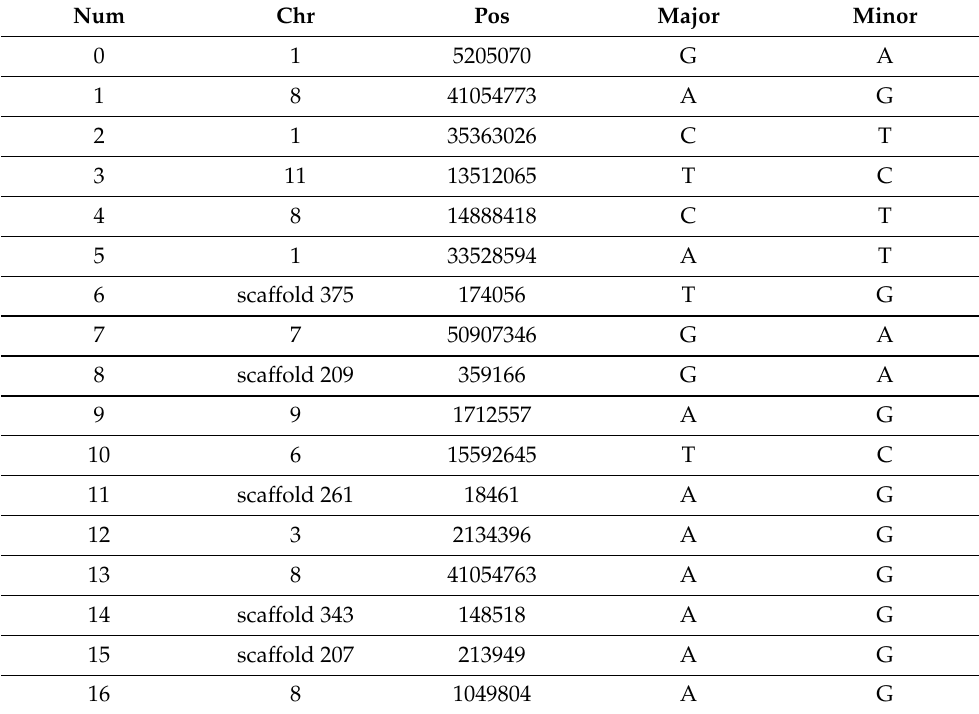
Figure 2. The Venn diagram for the selected SNP. The selection was performed using importance scores, the Boruta algorithm, and SHAP values. Table 1. The 17 Selected SNPs that make up the cross-SNP